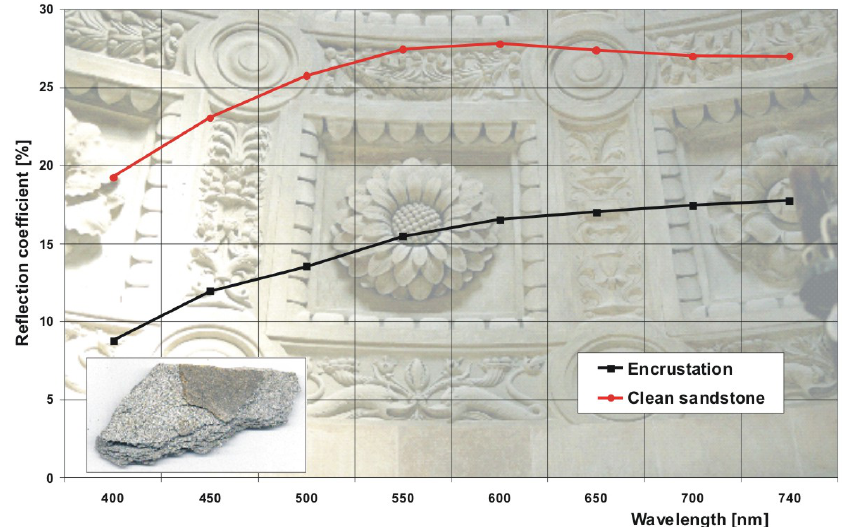
Figure 31. Reflection coefficient of two areas of My ś lenicki sandstone in the function of light wavelength. Left bottom corner – sandstone sample photograph. Diagram background – sandstone flower ornaments in the Sigismund